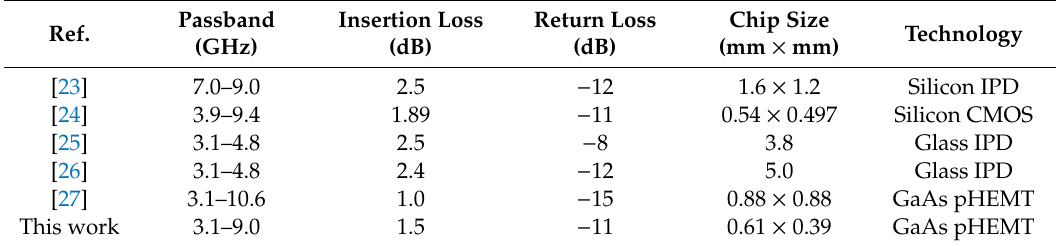
Table 3. Comparison of chip filters for UWB applications. IPD: integrated passive device.